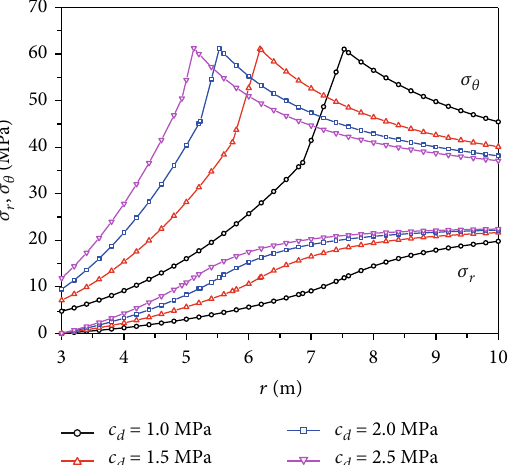
Figure 10: Comparison of stress distribution at the tunnel crown based on di ff erent types of residual